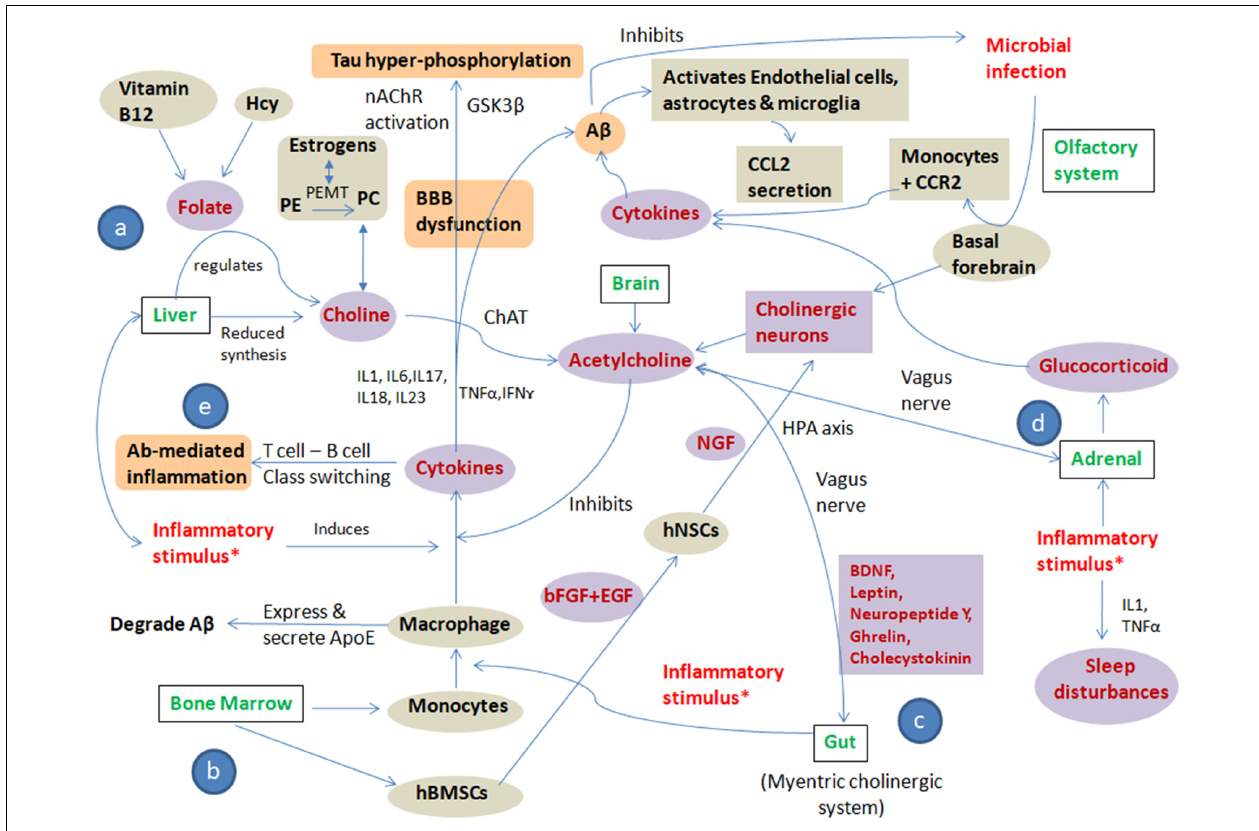
FIGURE 2 | Pathways showing systemic immune dyshomeostasis and the effect of inflammatory trigger insults on cholinergic signaling in AD: the figure shows crosstalk among “trigger insults/inflammatory stimulus” i.e., polymicrobial infection, chronic stress, pro-inflammatory diet and cholinergic signaling to put forward the “Systemic Immune Dyshomeostasis” model as to connect the events leading to AD development and progression. All three trigger insults lead to altered cholinergic signaling pathway in brain, bone marrow, liver and gut by modulating: (a) one carbon (1C) metabolism; (b) bone marrow-derived monocytes and bone marrow-derived mesenchymal stem cells (BMSCs); (c) gut microbiome, hypothalamic pituitary axis; and (d) glucocorticoid regulation culminating in immune alteration and autoimmunity (e). The Violet shaded circles represent the “direct players,” the gray shaded circles represent the “indirect players” and the orange shaded circles represent the “pathological players” in AD pathogenesis cascade. ∗ Infection, stress and inflammatory diet; Hcy, Homocysteine; PE, Phosphatidylethanolamine; PC, Phosphatidylcholine; PEMT, Phosphatidylethanolamine N-methyltransferase; ChAT, Choline O-Acetyltransferase; nAChR, Nicotinic acetylcholine receptors; GSK3 β , Glycogen synthase kinase 3 beta; IL, interleukins; TNF α , Tumor necrosis factor alpha; IFN γ , interferon γ ; hBMSCs, human bone marrow-derived mesenchymal stem cells; hNSCs, human neural stem cells; bFGF, basic fibroblast growth factor; EGF, Epidermal growth factor; NGF, Nerve growth factor; ApoE, Apolipoprotein E; A β , Amyloid beta; CCL2, C-C Motif Chemokine Ligand 2; CCR2, C-C chemokine receptor type